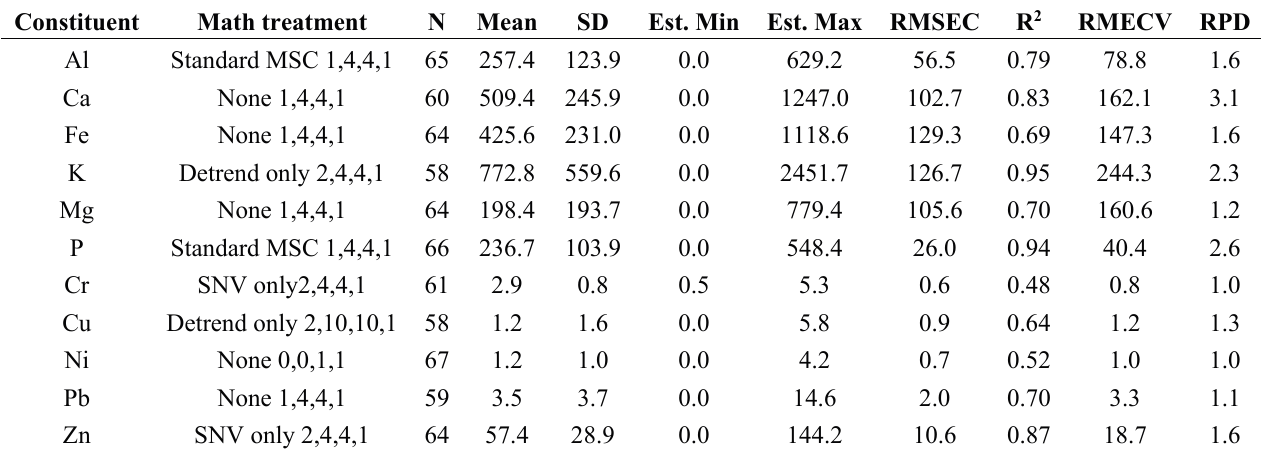
Table 3. Statistical descriptors of calibration by NIR of the